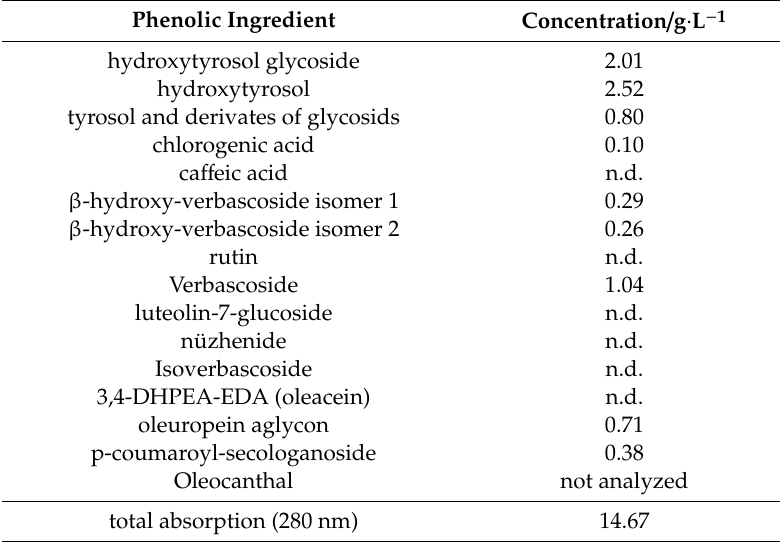
Table 1. Quantification of the phenolic ingredients in the olive mill wastewater (OMWW) extract, n.d. = not